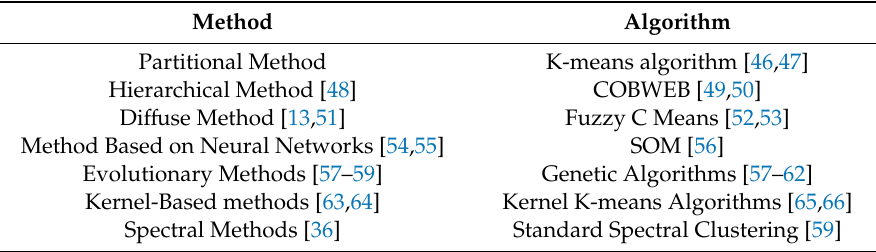
Table 1. Clustering’s methods and